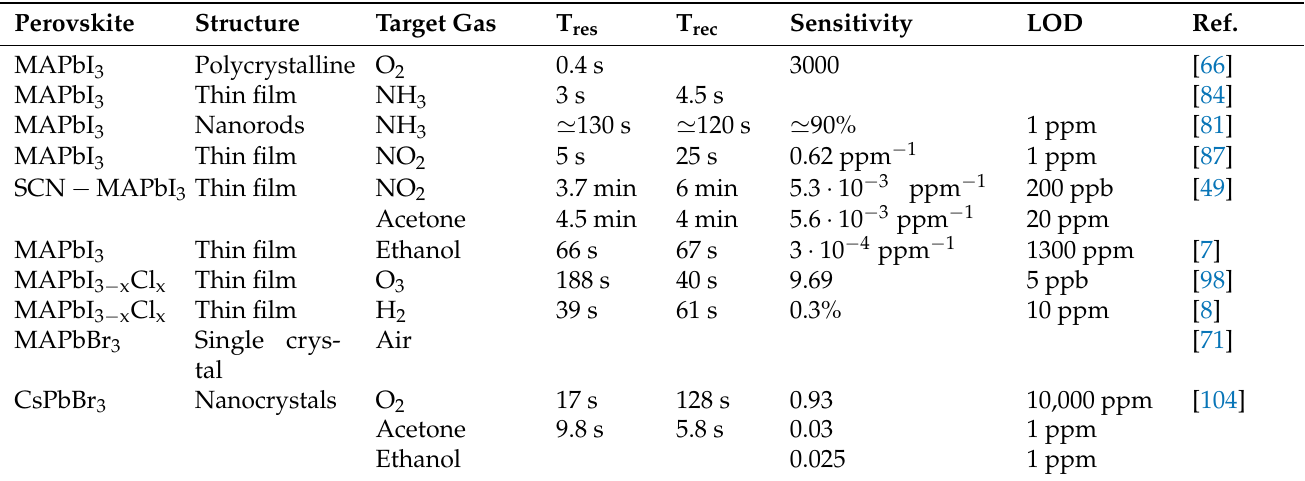
Table 1. Sensing properties for perovskite-based resistive sensors described in this review. Data are grouped taking into account the perovskite active mean. The morphology of the film, the target gas used as analyte and the main sensing properties are